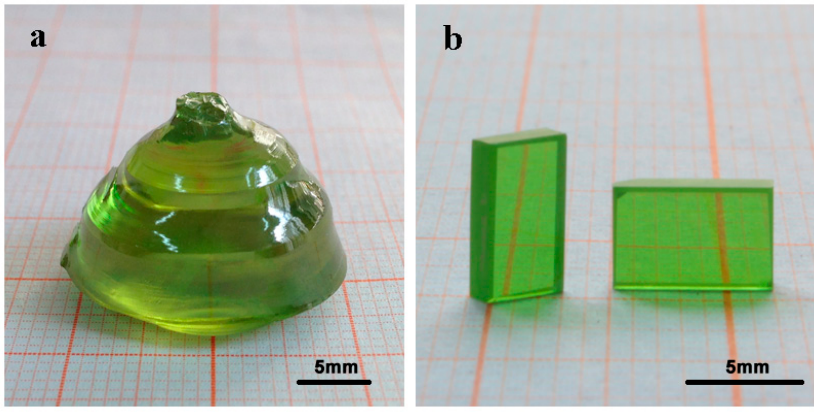
Figure 1. Photographs of as-grown PSO single crystal ( a ), and polished wafers ( b